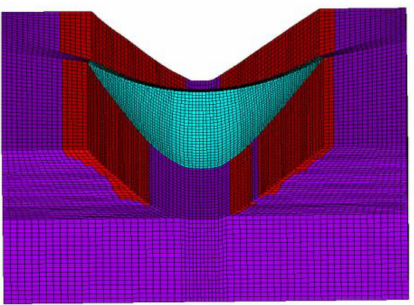
Figure 2. The FE model of the arch dam–foundation system.